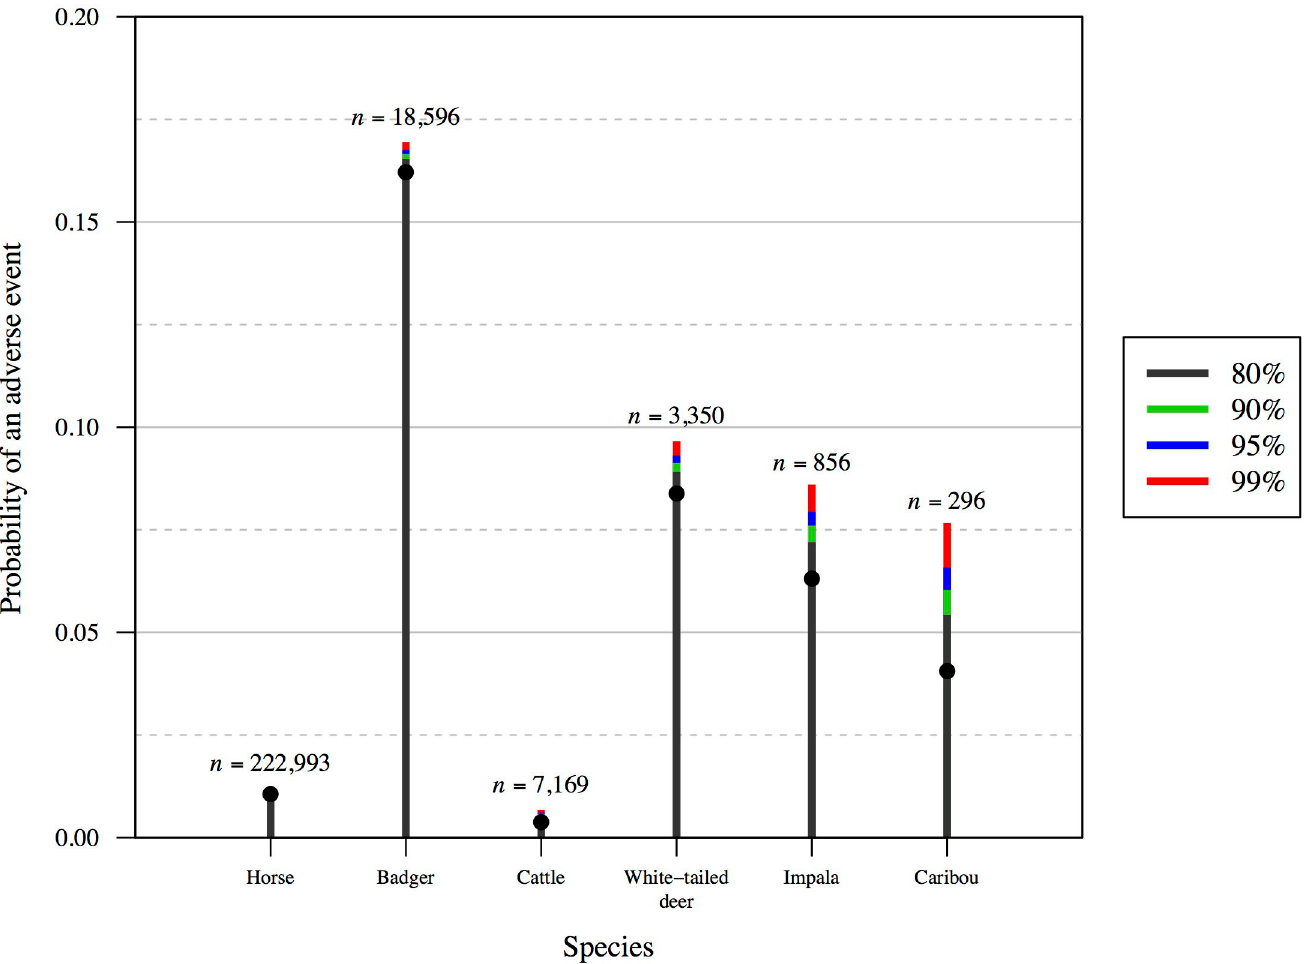
Fig 3. One-sided confidence interval estimates for adverse event frequency estimates from six published animal welfare studies of operational (not research) activities. Point estimates are shown (grey dots), as are the following confidence intervals: 80% (grey), 90% (green), 95% (blue) and 99% (red). For those studies that used sample sizes < 1000, the confidence intervals are relatively wide for estimating frequencies, whereas for those that used sample sizes > 1000 the confidence intervals are relatively narrow. For study details, see Table 1.